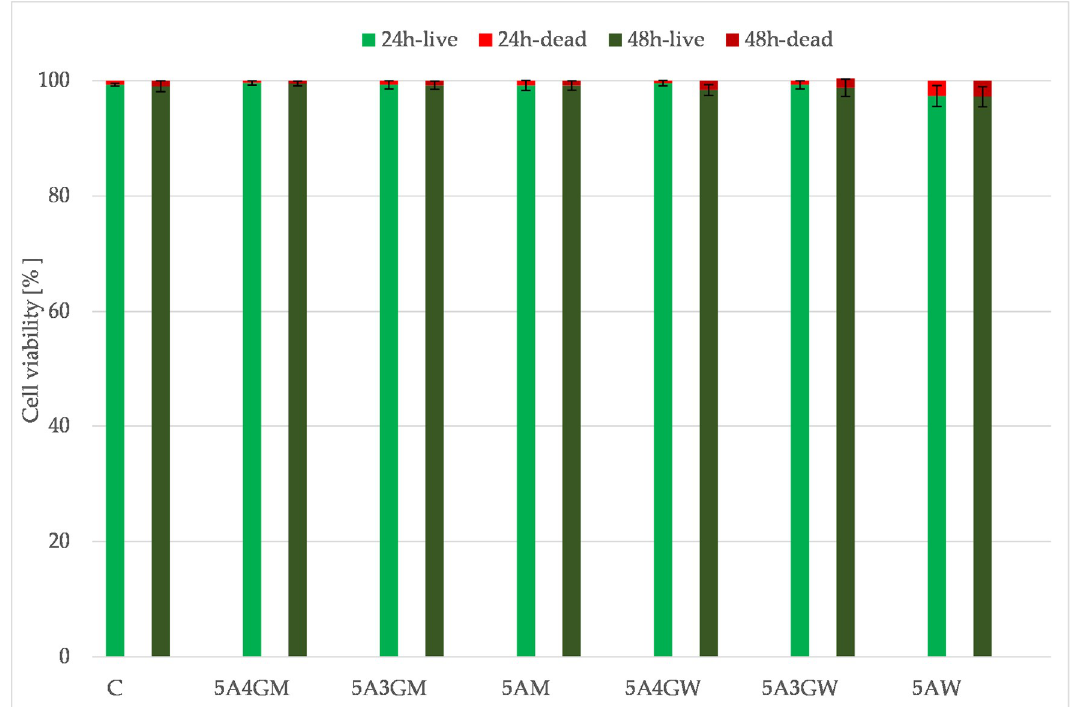
Figure 8. Endothelial cells (EA.hy 926 line) cytotoxicity after direct contact with 5A4GW and 5A4GM samples after 24 ( a , c ) and 48 h ( b , d ) of incubation (live cells are marked green, dead in red). Magnification 100x.